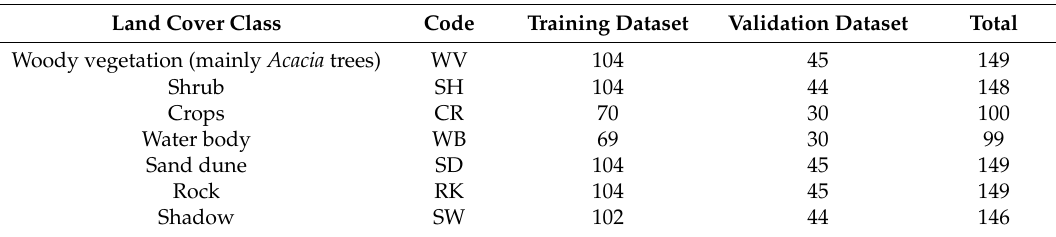
Table 2. Number of training and validation datasets collected for different land cover classes in the study